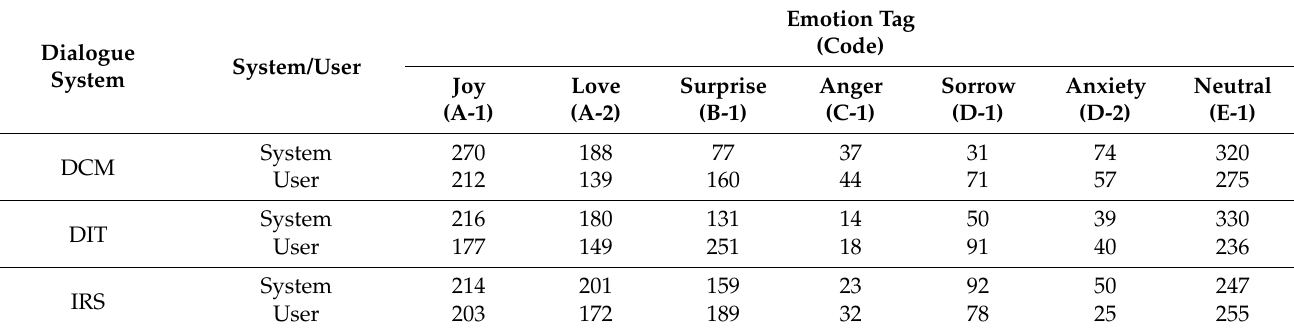
Table 10. Number of annotated tags for each dialogue